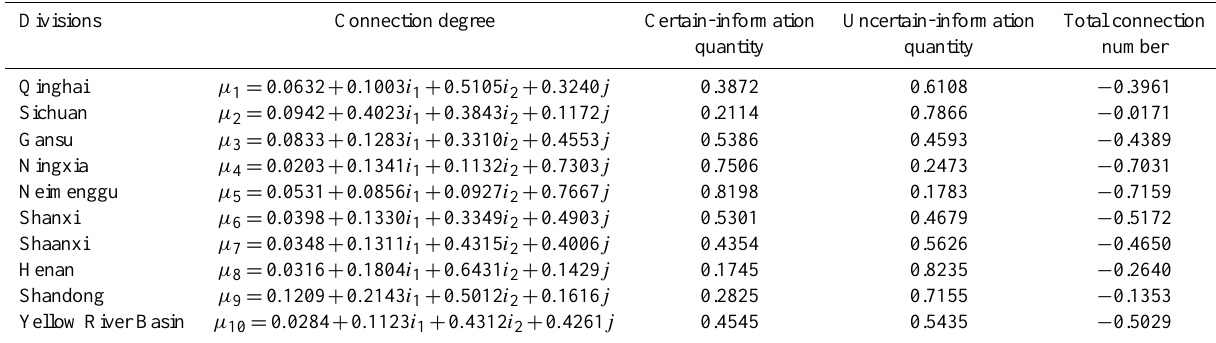
Table 6. The connection degree, connection number, certain-information quantity and uncertain-information quantity of water resource renewability in the Yellow River Basin.